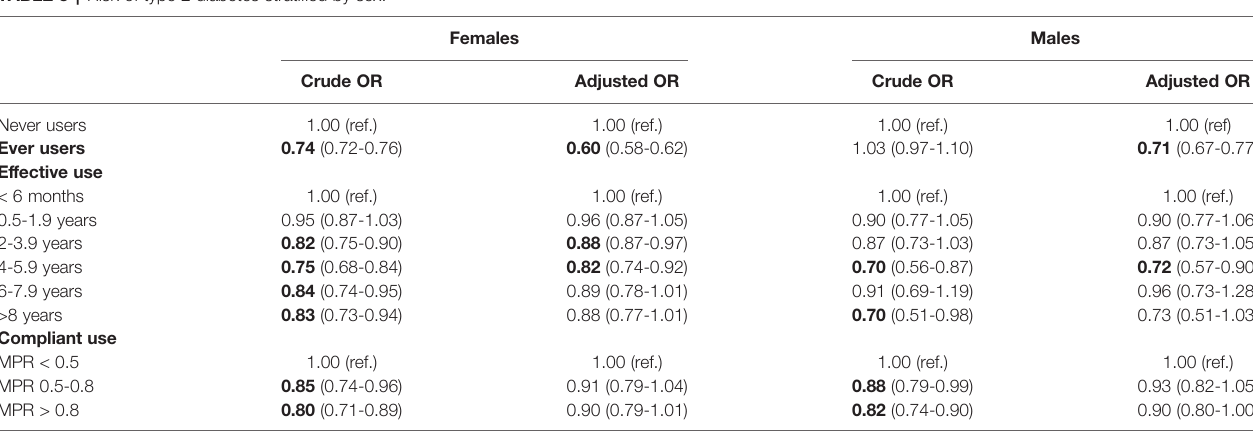
TABLE 3 | Risk of type 2 diabetes strati fi ed by sex.